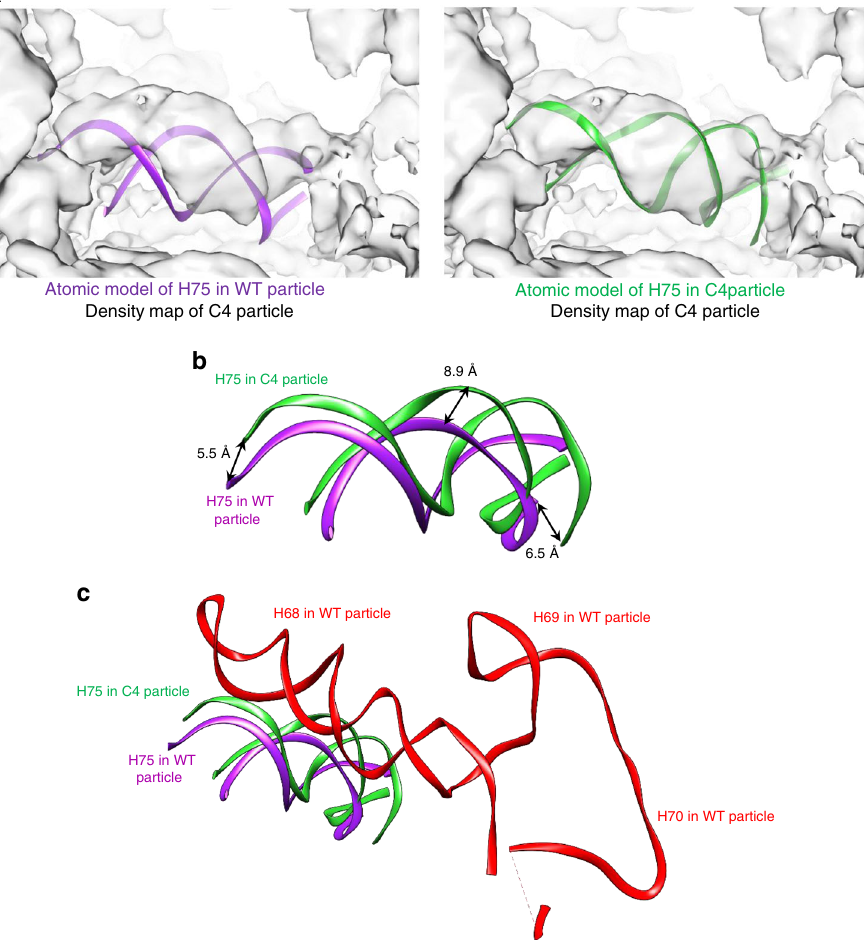
Fig. 5 H75 is de fl ected in the C4 class of rpf2 Δ 255-344 particles and clashes with H68. a The atomic model for H75 of wild-type particles (left) or the C4 class of rpf2 Δ 255-344 mutant particles (right), was fi tted into the density map of the C4 class of rpf2 Δ 255-344 particles. b Atomic models for H75 in wild-type and C4 particles were aligned. H75 is de fl ected up to 8.9 Å in the C4 class compared with wild-type particles. c H75 in the C4 class of the rpf2 Δ 255-344 particles clashes with the position of H68 in wild-type particles. H68-H70 are not visualized in the C4 class due to their fl